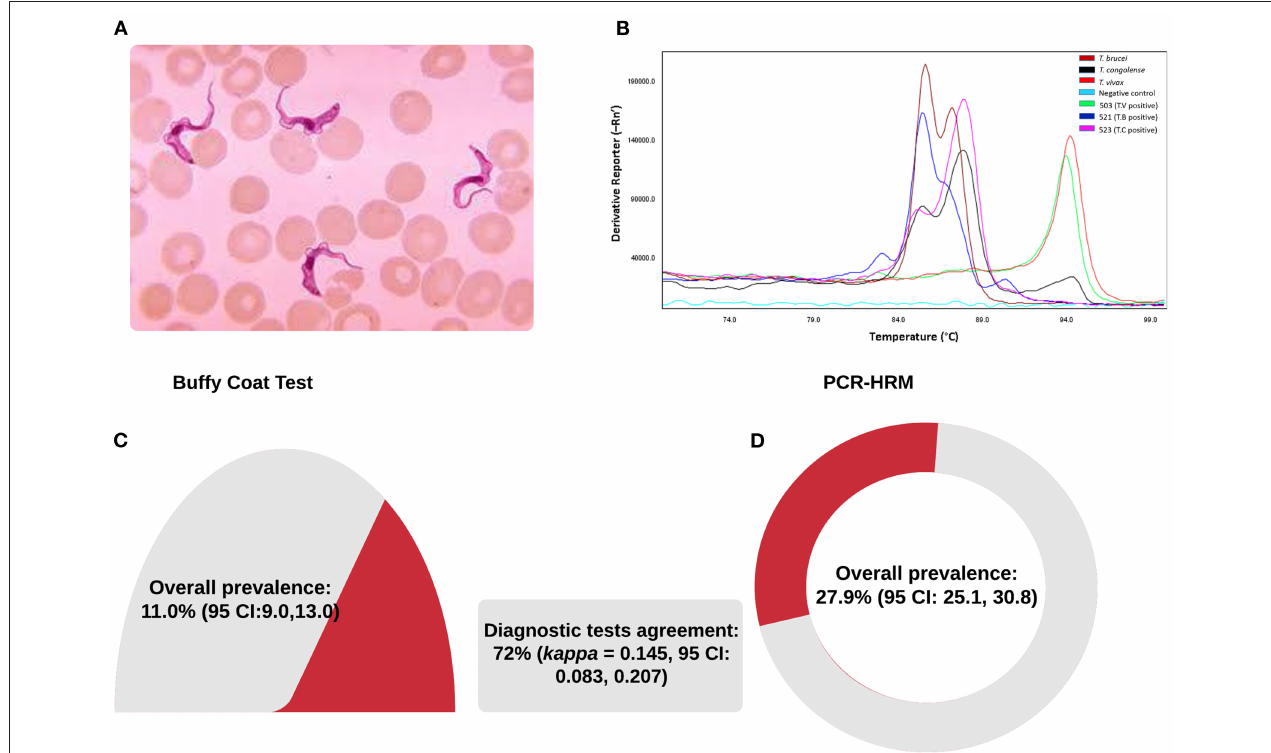
FIGURE 3 | Trypanosome species as identified by microscopy (A) , PCR-HRM (B) , and prevalence (C,D) .